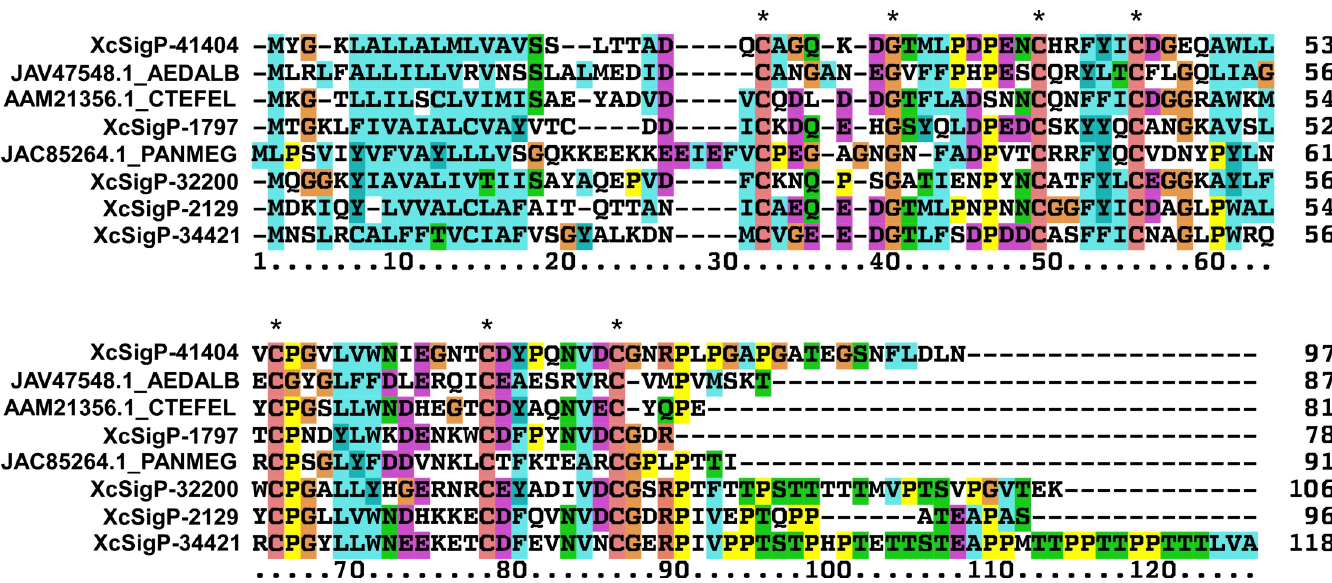
Fig 4. Alignment of differentially regulated X . cheopis peritrophin-like genes with those of other insects. Multiple sequence alignment of X . cheopis peritrophins (XcSigP-41404, -1797, -32200, -2129, and -34421; Table 5) with peritrophin sequences of A . albopictus (JAV47548.1), C . felis (AAM21356.1), and P . megistus (JAC85264.1). Asterisks highlight conserved cysteine residues of the peritrophin A domain.